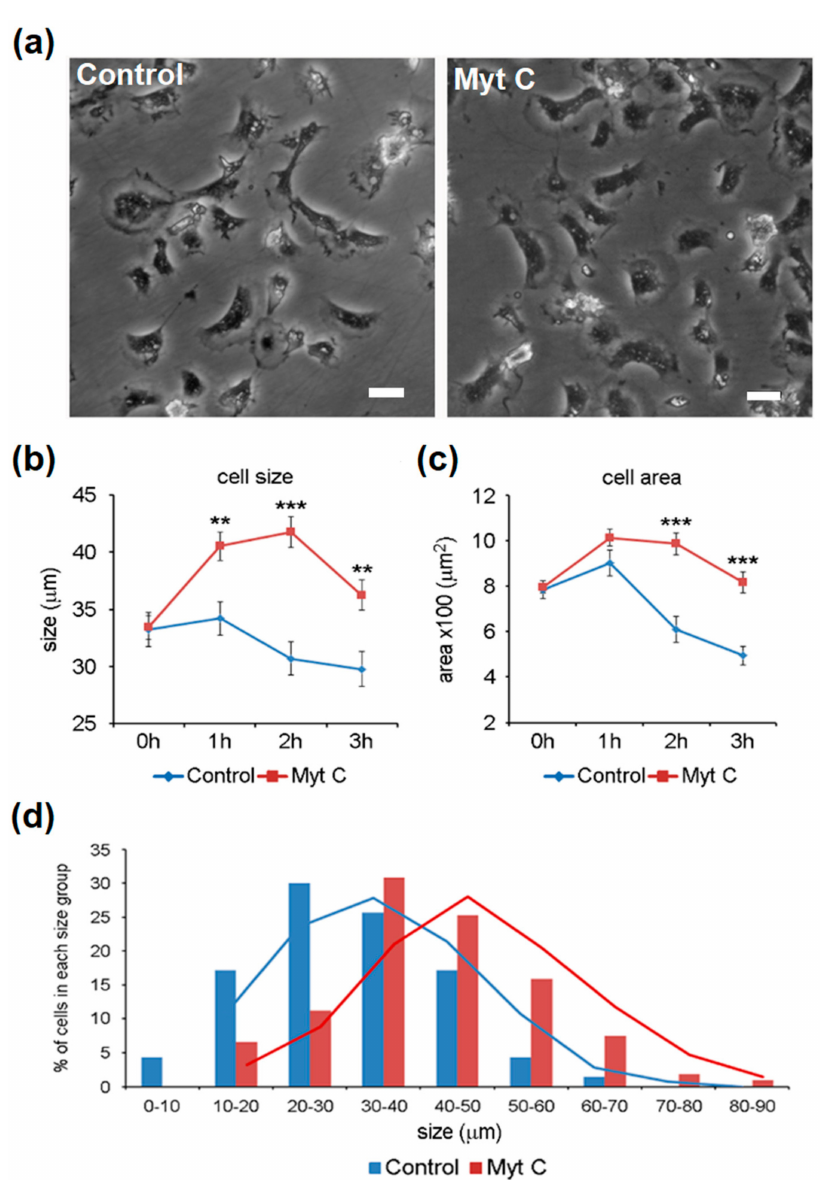
Figure 3. ( a ) Appearance of cells after 2 h of treatment with myticin C. Cell size analysis using ( b ) maximum length and ( c ) area measurements. Asterisks indicates significant di ff erences at p < 0.01 (**) and p < 0.001 (***). ( d ) Distribution of cells in di ff erent size groups after 3 h of